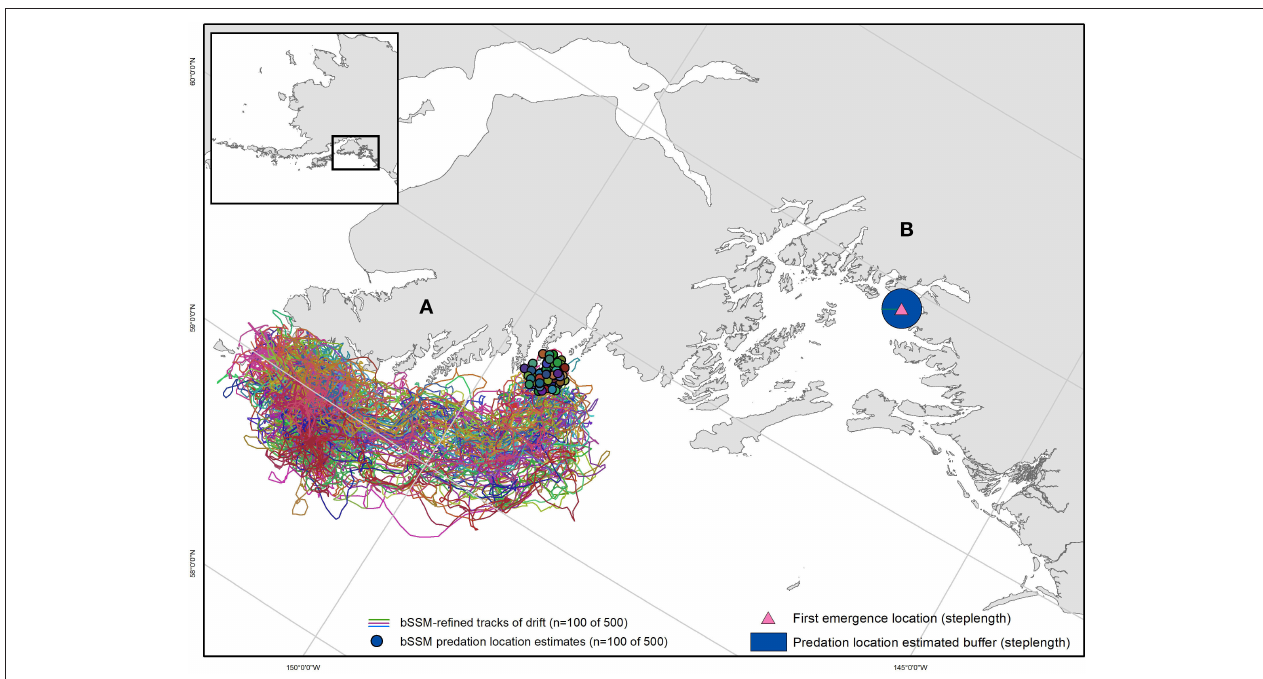
FIGURE 2 | Two examples of mortality location and uncertainty estimation methods. (A) For data with < 24h uplink delay, state-space model simulations were run in reverse (bSSM), utilizing all available Argos location estimates post-emergence to generate a predicted emergence (predation) location. For each observed predation event, 500 bSSM simulations were run, resulting in 500 predation location estimates. A subset of LHX2_07’s bSSM simulation tracks are shown here ( n = 100), with estimated predation locations clustered around the Chiswell Islands. (B) For data with > 24hr uplink delay, a step-length calculation generated a buffer around the emergence location within which predation was estimated to have occurred. The first emergence location for TJ44, and estimated predation location buffer in Prince William Sound are shown.